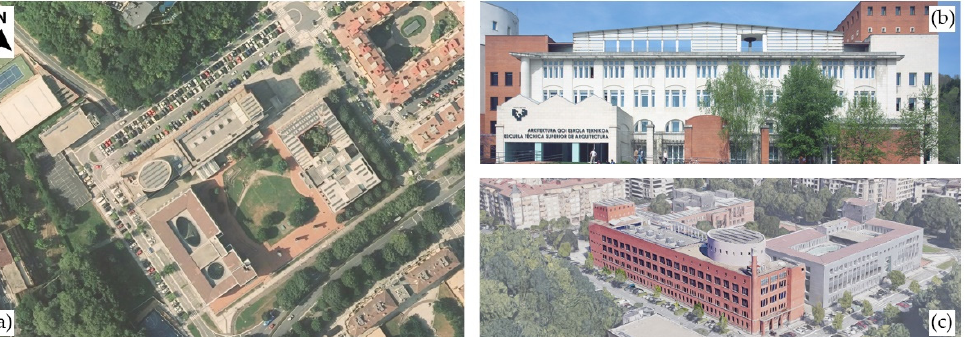
Figure 4. Location of the case study. ( a ) Aerial view. Source: Geoeuskadi. ( b ) Front façade (south), where A 1.1 is located. Source: UPV-EHU. ( c ) Perspective of the north façade oriented to the parking lot. Note that A 2.1 and the Administration space studied are located in this façade. Source: Google Maps.